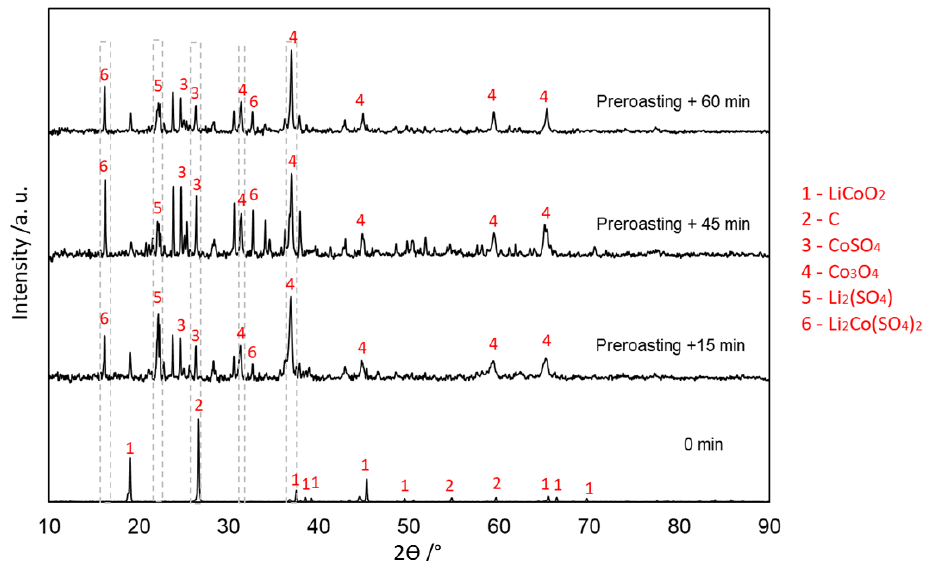
Figure 10. XRD pattern for 15-min, 45-min, and 60 min sulfation roasted samples with additional pre-roasting.